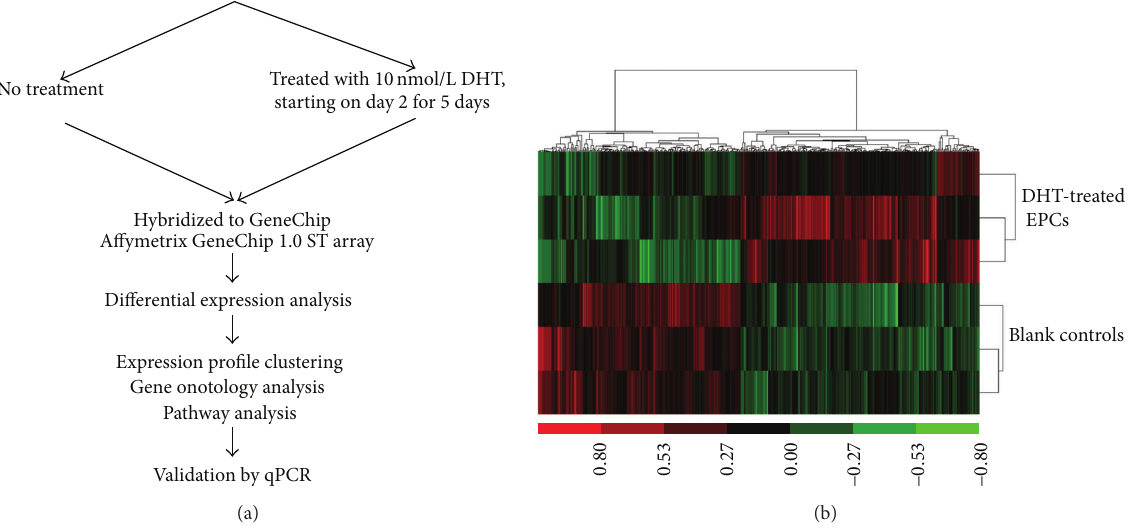
Figure 5: Microarray data analysis workflow and cluster analysis of gene expression profiles in DHT-treated and nontreated EPCs. (a) EPCs were isolated from mouse bone marrow. RNA samples were extracted from DHT-treated and nontreated EPCs and hybridized to Affymetrix GeneChip microarrays. (b) The cluster analysis of gene expression profiles. High expression is indicated in red, whereas low expression is coded in green. Each row corresponds to the expression profile of a mouse sample, and each column corresponds to a